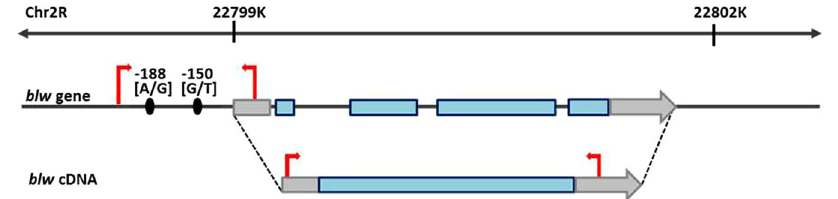
Figure 1. Diagram of the structure of the D. melanogaster blw gene. The blw gene is located on Chr 2R :22,799,099 … 22,802,180 [ + ] and generates a single transcript composed of a 5 ′ -UTR (gray box), four exons (blue boxes) and a 3 ′ -UTR (gray arrow) (Flybase.org). The two SNPs are located 150 bp [G/T] and 188 bp [A/G] upstream of the blw transcriptional start site (gray box). The location of PCR primers used to generate the blw -promoter or blw -cDNA are indicated by red arrows.